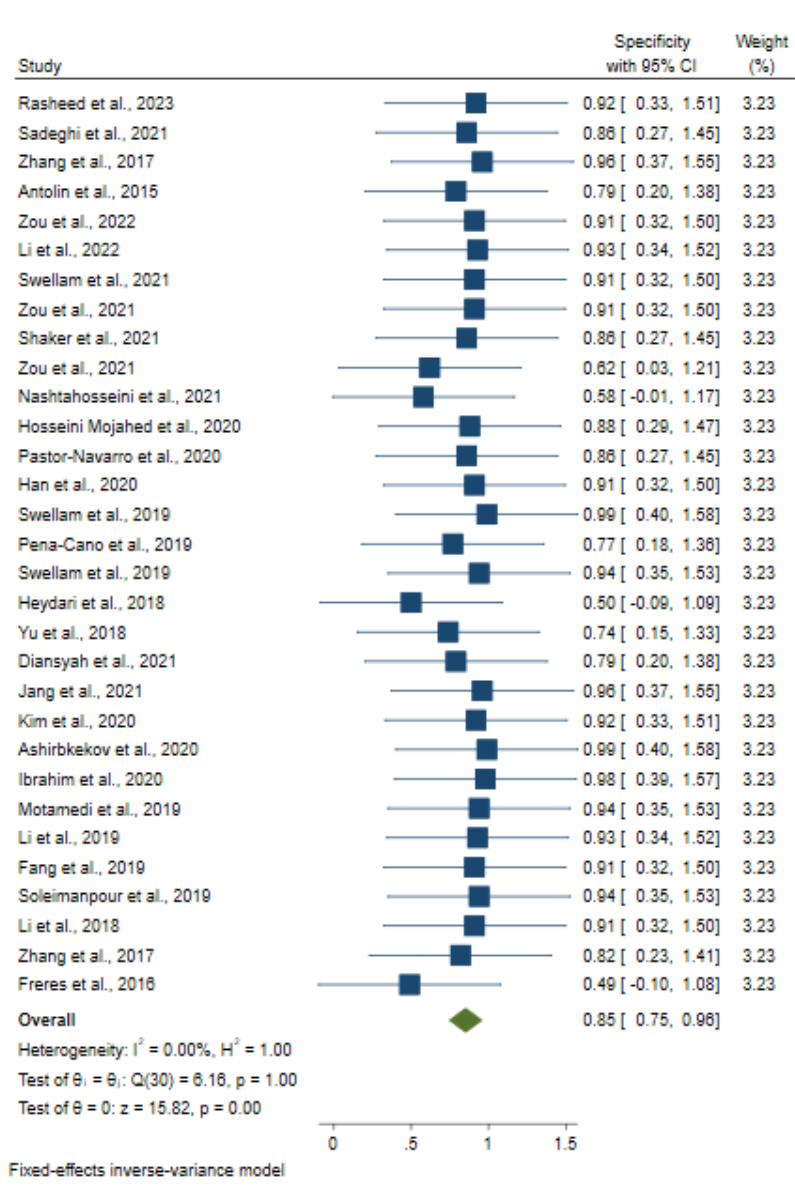
Fig. 10. Specificity of circulating microRNAs to diagnose breast